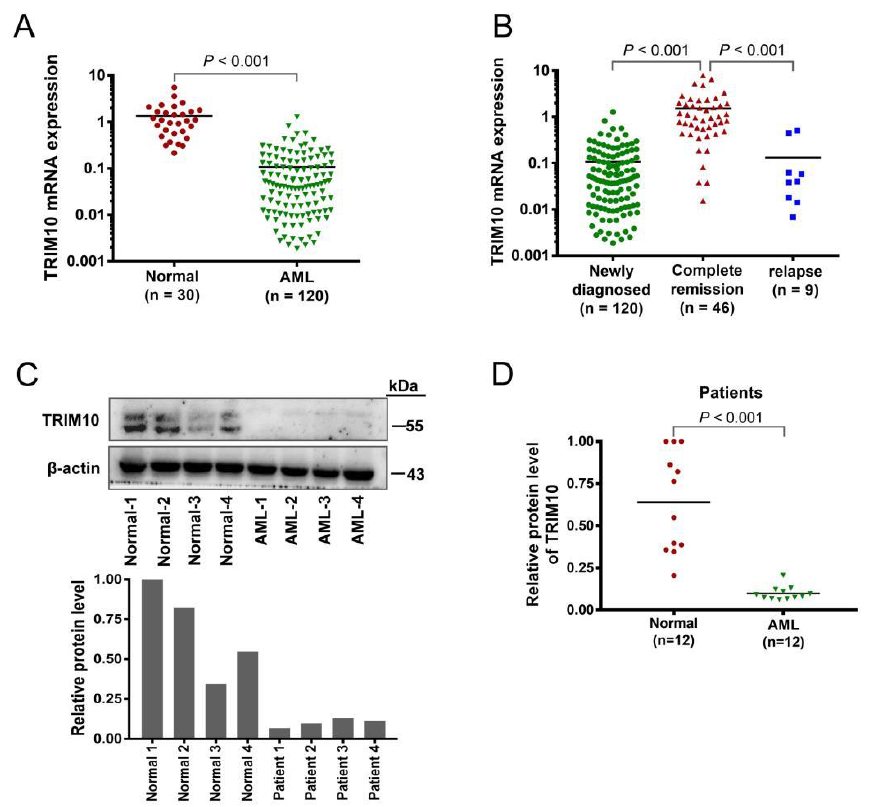
Figure 1. Downregulation of TRIM10 in AML patients. ( A ) Analysis of TRIM10 mRNA expression in 120 AML patients and 30 normal controls determined by quantitative real-time PCR analysis (qRT-PCR). ( B ) Analysis of TRIM10 mRNA expression in patients with newly diagnosed AML ( n = 120), the relapsed patients ( n = 9) and patients with complete remission ( n = 35). ( C ) Representa- tive western blot analysis of TRIM10 expression in patients with AML ( n = 12) and normal controls ( n = 12). ( D ) Statistical analysis of TRIM10 protein expression in ( C